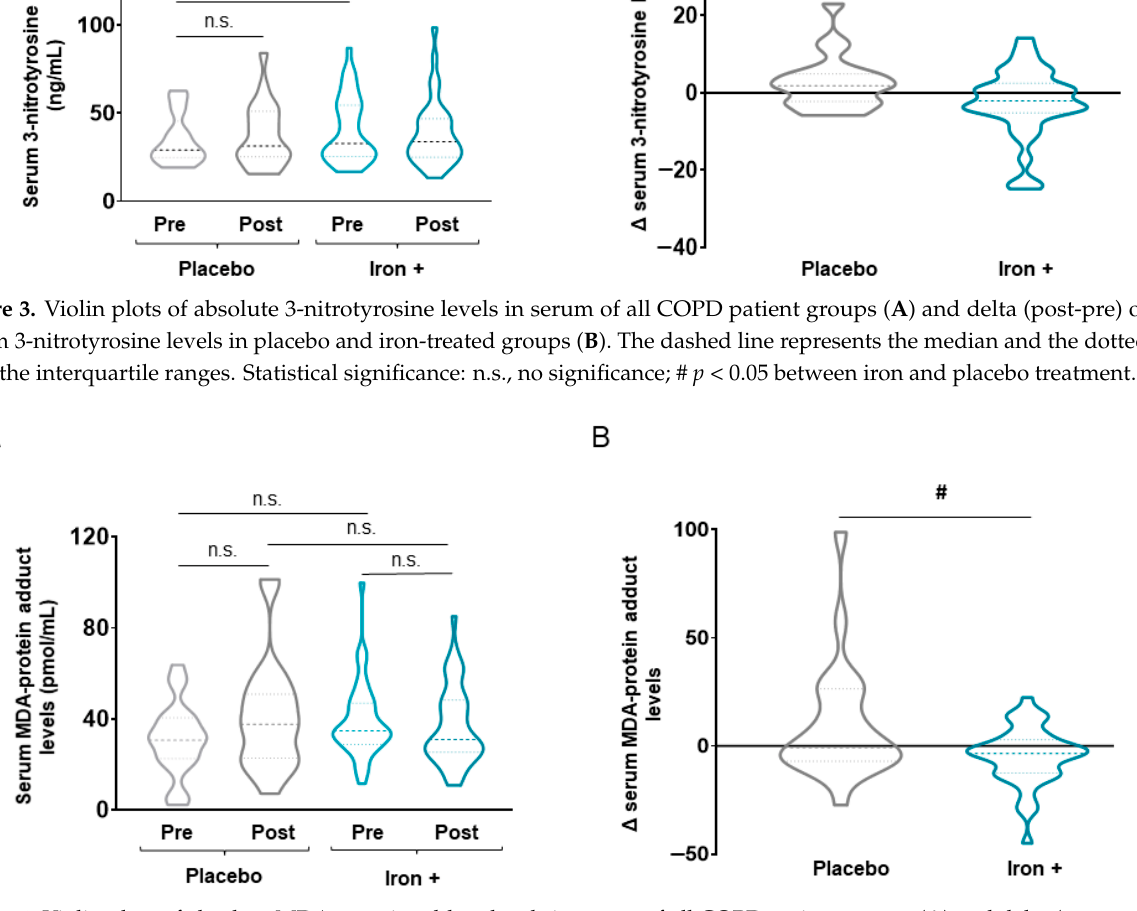
Figure 4. Violin plots of absolute MDA-protein adduct levels in serum of all COPD patient groups ( A ) and delta (post-pre) of serum MDA-protein adduct levels in placebo and iron-treated groups ( B ). The dashed line represents the median and the dotted lines the interquartile ranges. Statistical significance: n.s., no significance; # p < 0.05 between iron and placebo treatment. Definition of abbreviations: MDA, malondialdehyde.